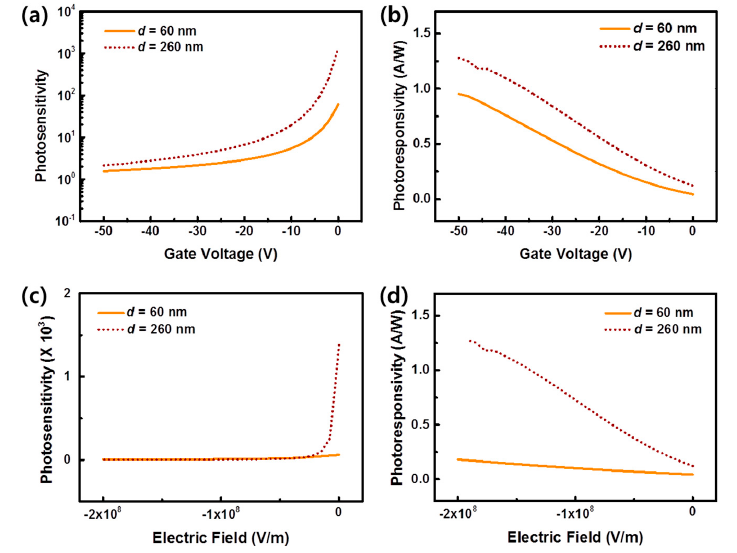
Figure 3. The photosensitivity and photoresponsivity of OPTs with PVP layers thickness d = 60 nm and d = 260 nm: ( a ) Photosensitivity and ( b ) photoresponsivity with various gate voltages; ( c ) Photosensitivity and ( d ) photoresponsivity under various electric fields.